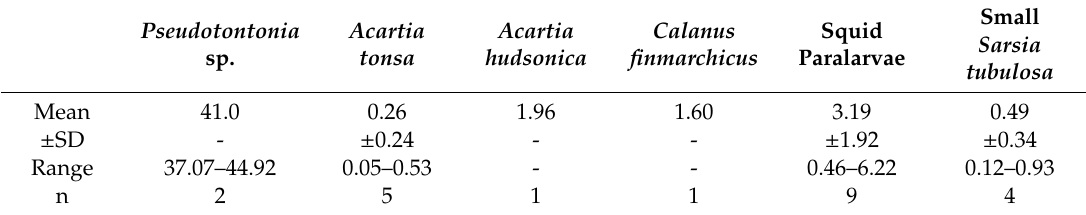
Table 1. Summary of the calculation results of the added mass coe ffi cient.